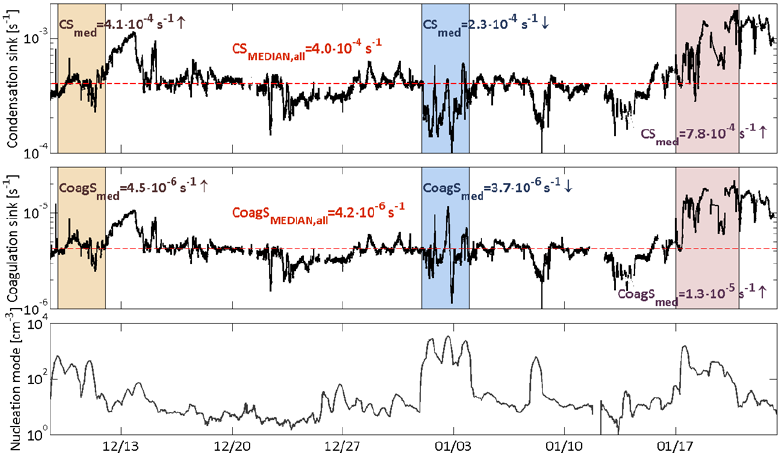
Fig. 13. Condensation and coagulation sinks and nucleation mode concentration during the measurement campaign. The uppermost and middle panel show the condensation and coagulation sink during the whole measurement campaign, respectively. The lower panel shows the nucleation mode concentration as calculated from DMPS for the same time period. The event periods are shaded with light yellow (9 to 11 December 2009), light blue (1 to 3 January 2010) and pink (17 to 20 January 2010). Median CS and CoagS values for the event periods and for the whole measurement campaign are shown as well. The coagulation sink was calculated for 11nm sized particles.